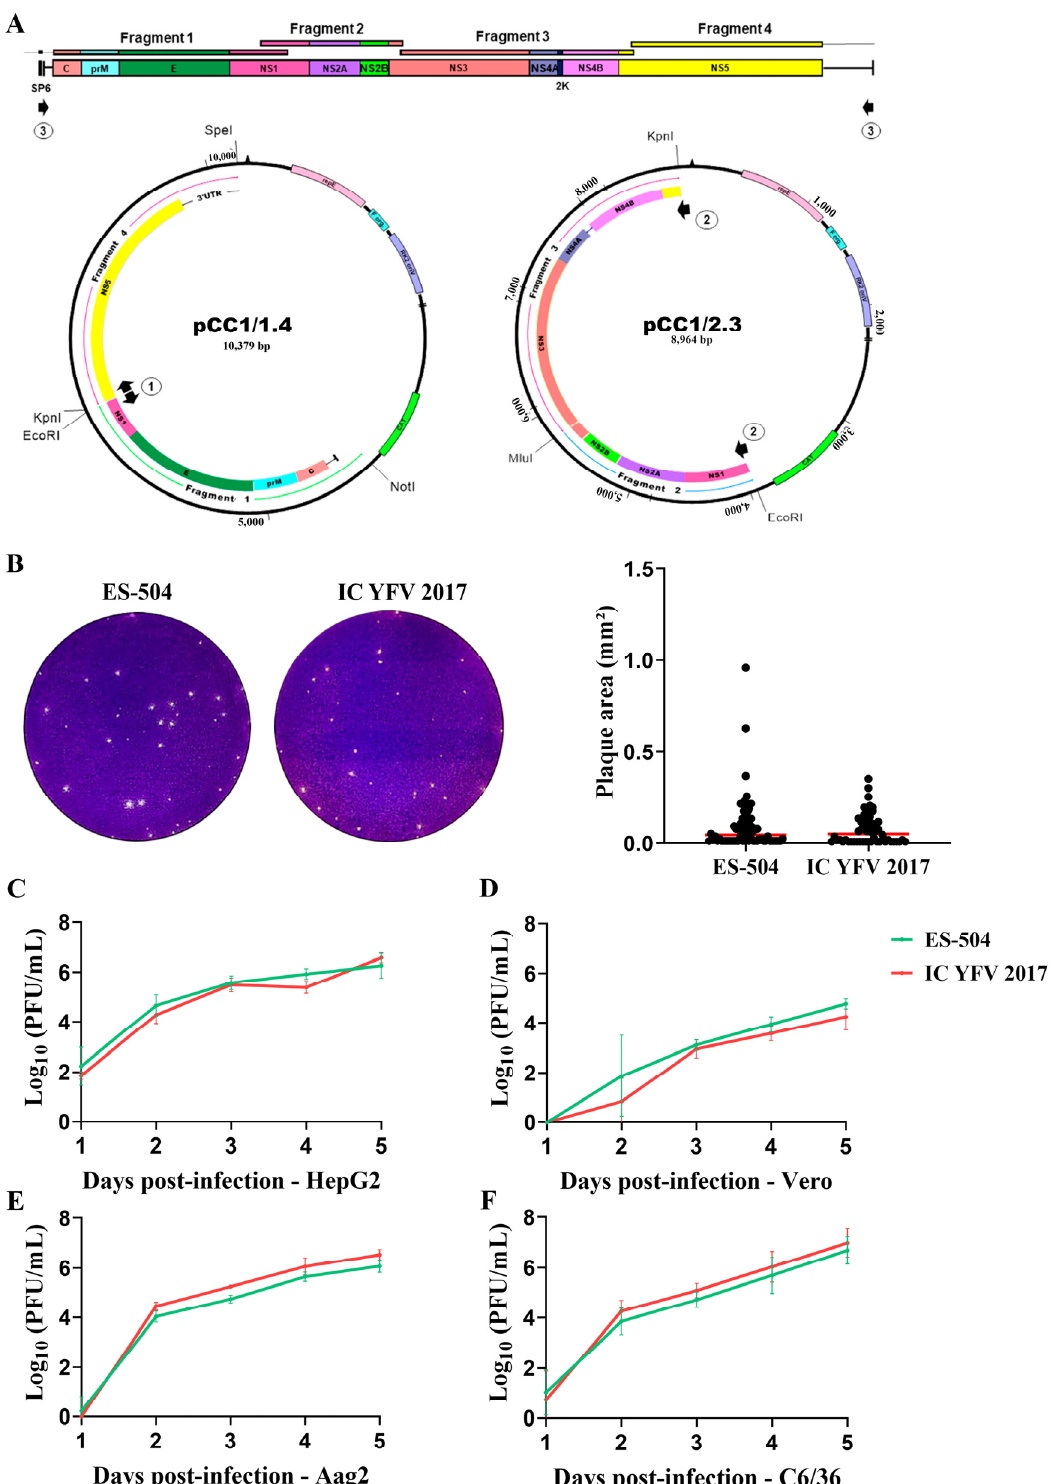
Figure 2. Recovery and assessment of clone-derived YFV. ( A ) Strategy for the assembly of YFV genome. The genome was divided into 4 fragments and reassembled into two main plasmids bearing the extremities (pCC1/1.4) and the central part (pCC1/2.3) of the viral cDNA. Black arrows 1 to 3 represent the primer pairs used in the amplification rounds before in vitro transcription of the template cDNA as described in section 2.2 and Supplementary Table S1. Arrows numbered 1 represent the primer pair used to amplify the entire plasmid pCC1/1.4, arrows numbered 2, the primer pair employed in the amplification of the central part of the genome (fragment 2.3), and arrows numbered 3, are the primers used to amplify the complete viral cDNA. ( B ) Plaque